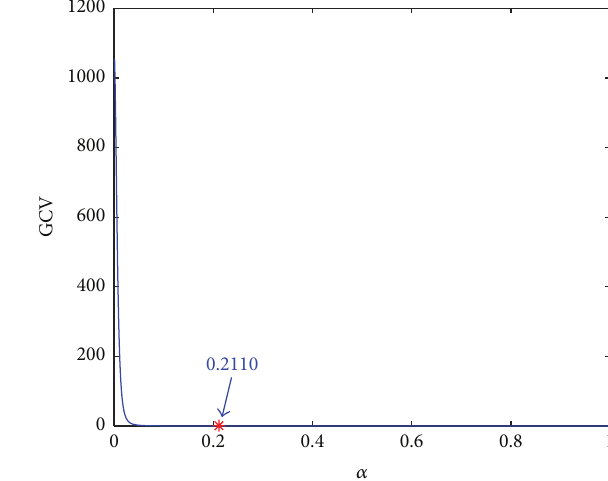
Figure 11: GCV for sine load identification of SISO system.